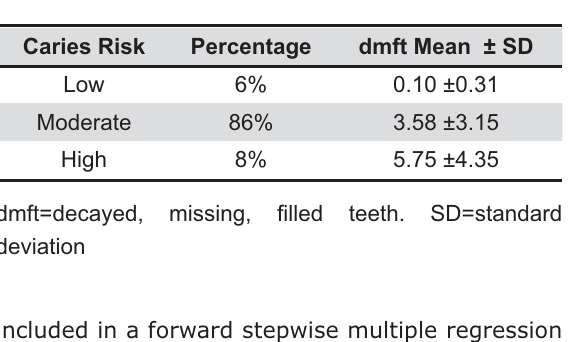
Table 1- Children distribution and mean dmft according to caries risk